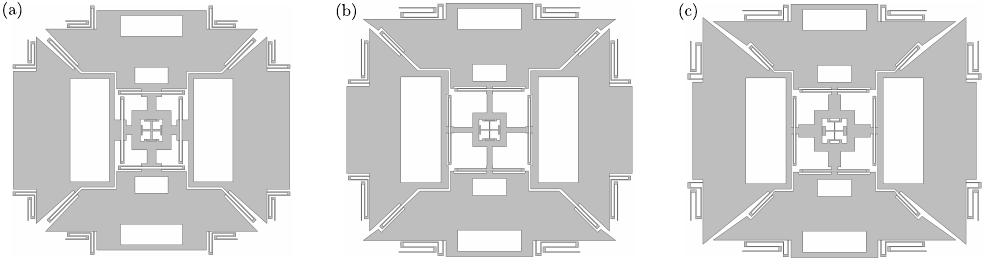
Figure 8. ( a ) Initial layout guess, ( b ) layout optimized by solving (P1), ( c ) layout optimized by solving (P2).